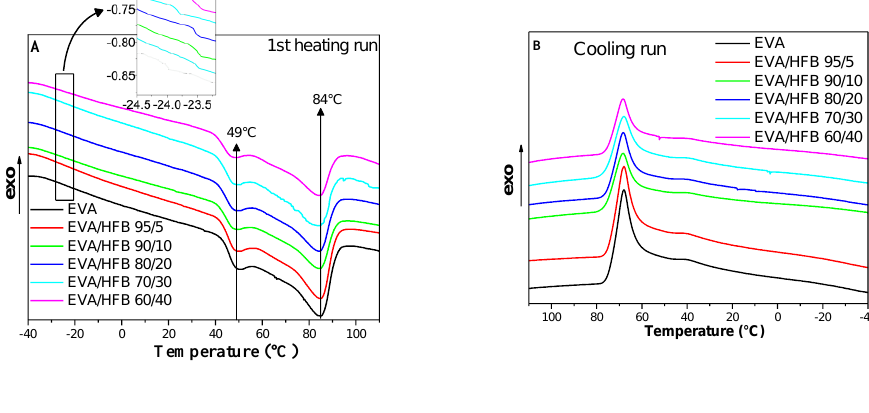
7 of 17 Table 1. Thermal parameters of EVA and EVA composites. Samples